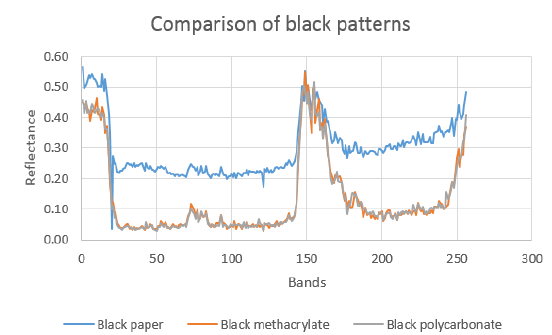
Figure 7. Comparison of the spectral signatures of the black patterns (normalization with